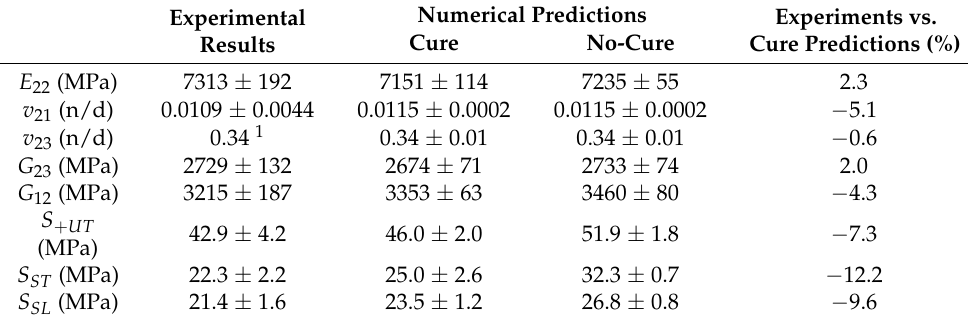
Table 8. Effective mechanical properties comparison. Numerical Predictions Experiments Experimental Results